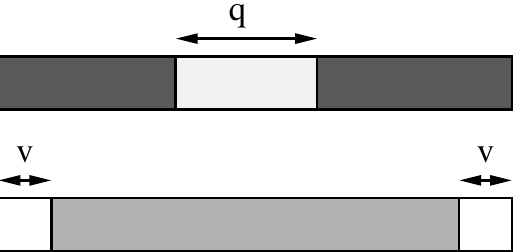
Figure 6. A schematic representation of the two possible cases mentioned in Lemma 5. The boxes represent the A string and the density of the filling represents the density of errors with B . q